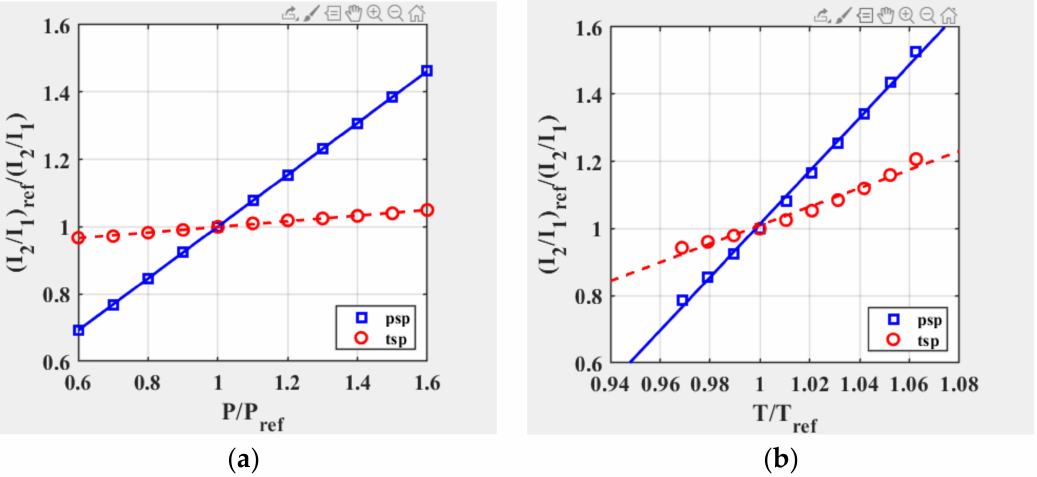
Figure 7. Calibration results for PSP and TSP. ( a ) Pressure calibration. ( b ) Temperature